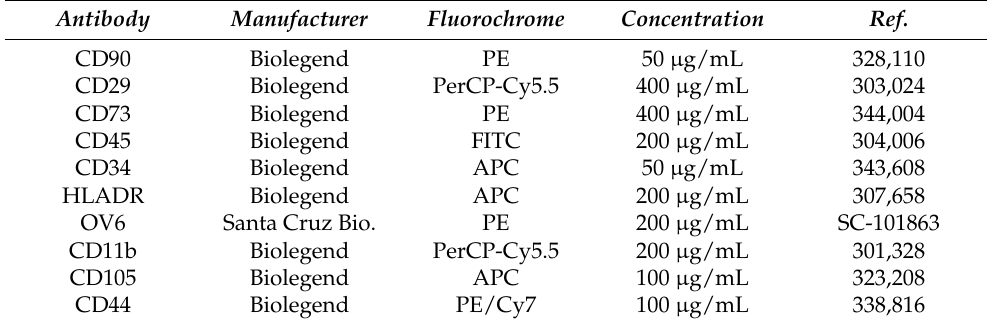
Table 4. Antibodies used for flow